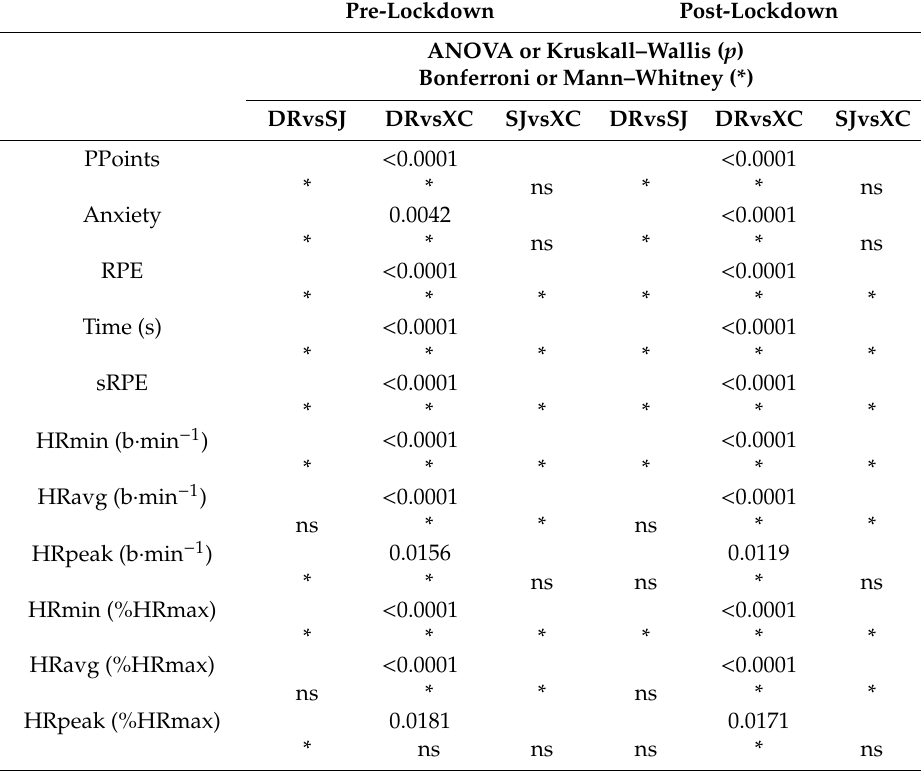
Table 3. Di ff erences among dressage (DR), show-jumping (SJ) and cross-country (XC) for competition performance (PPoints), anxiety, rating of perceived exertion (RPE), test duration (time), session RPE (sRPE) and minimum (HRmin), average (HRavg), peak (HRpeak) heart rate absolute and relative values are reported for pre and post lockdown